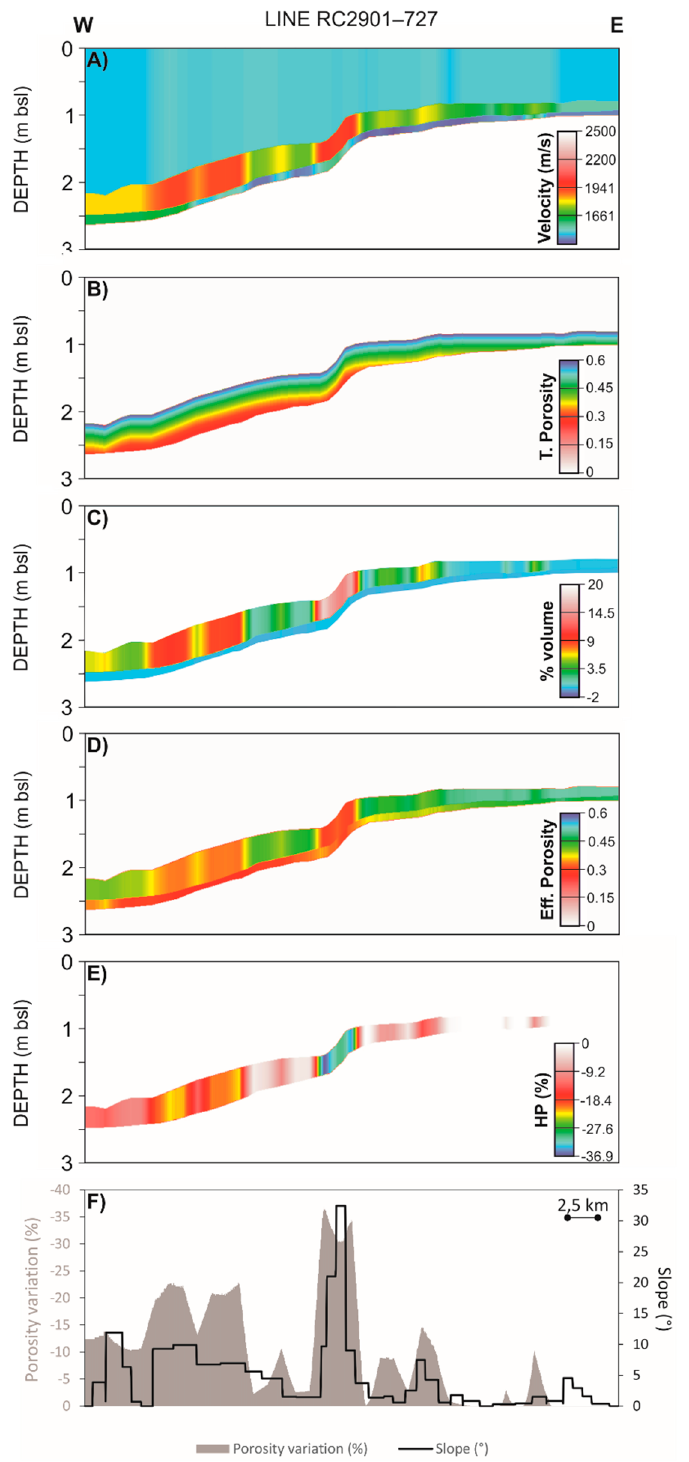
Figure 2. ( A ) Seismic model of inverted layers on line RC2901–727. ( B ) Theoretical porosity used for estimating the velocity distribution in the absence of gas-phase and to calculate the HP. ( C ) Gas hydrate (positive values) and free gas (negative values) concentration model on line RC2901–727. ( D ) Reduced porosity because of the hydrate presence on line RC2901–727. ( E ) HP section. ( F ) HP variations due to the gas hydrate presence (grey area) and slope variation (black line) on line RC2901–727.